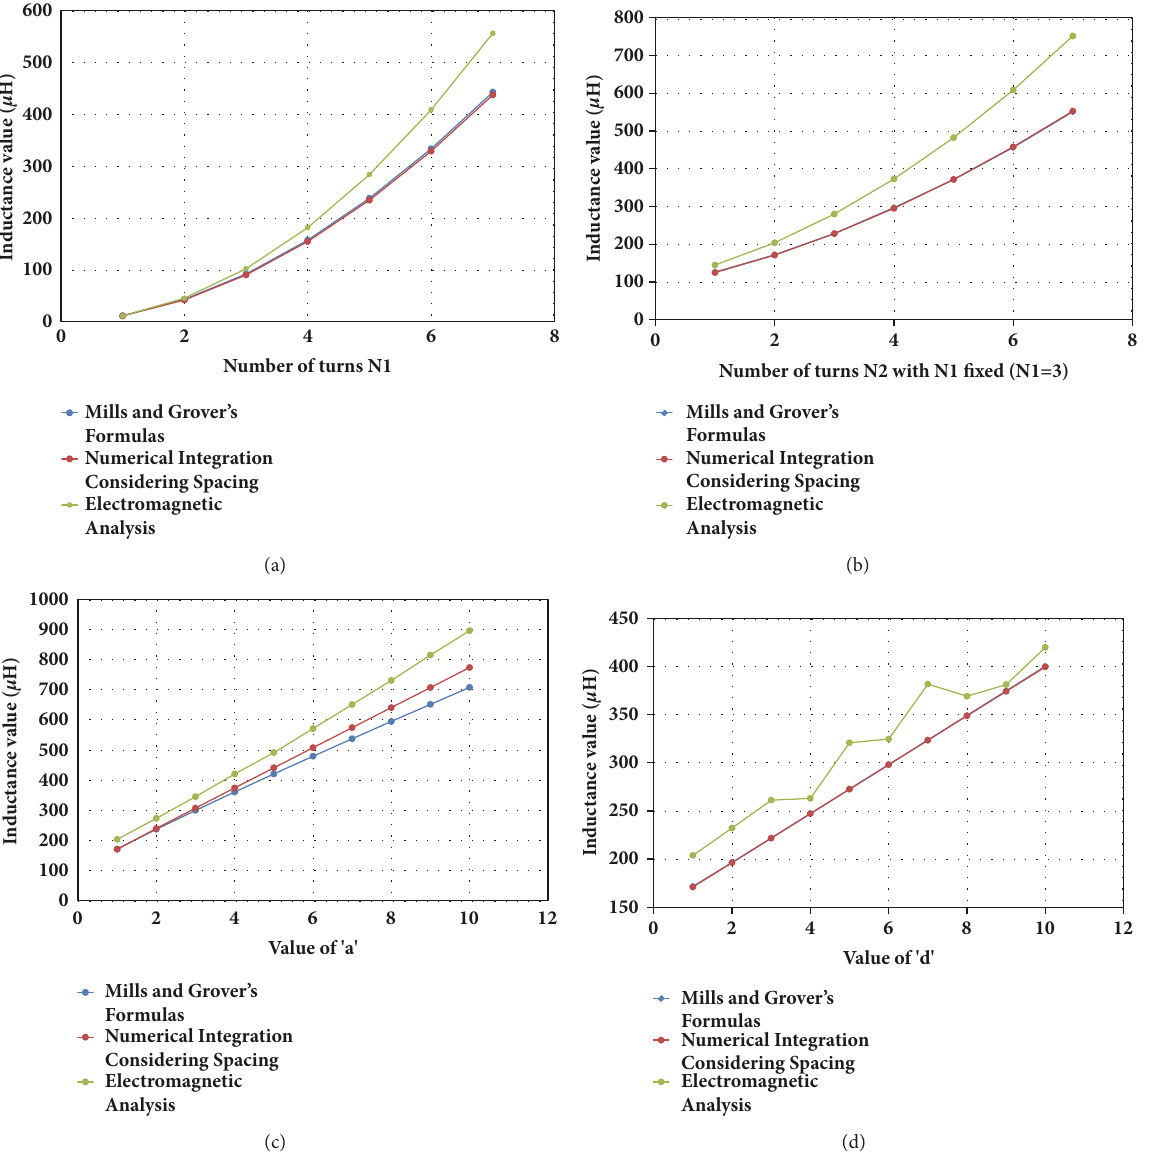
Figure 14: Inductance values. (a) When increasing the number of turns in a single loop. (b) When increasing the number of turns in a double loop. (c) When increasing the length of “a” in a double loop. (d) When increasing the length of “d” in a double